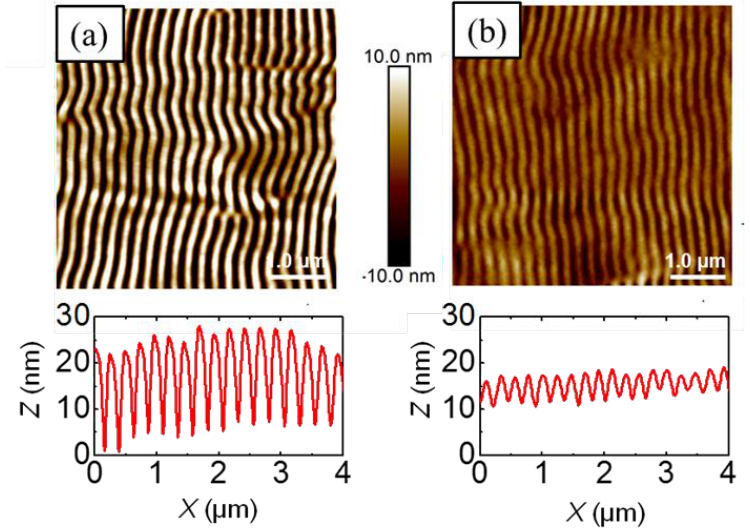
Figure 5. Topography AFM images of LIPSS fabricated at λ laser = 266 nm in vacuum with a fluence of 13.5 mJ/cm 2 and 3600 pulses on P3HT:PC 71 BM: ( a ) Before and ( b ) after an annealing step for 4 min at 140 ◦ C. In this case, the average period and depth are 230 ± 5 and 8 ± 2 nm, respectively.